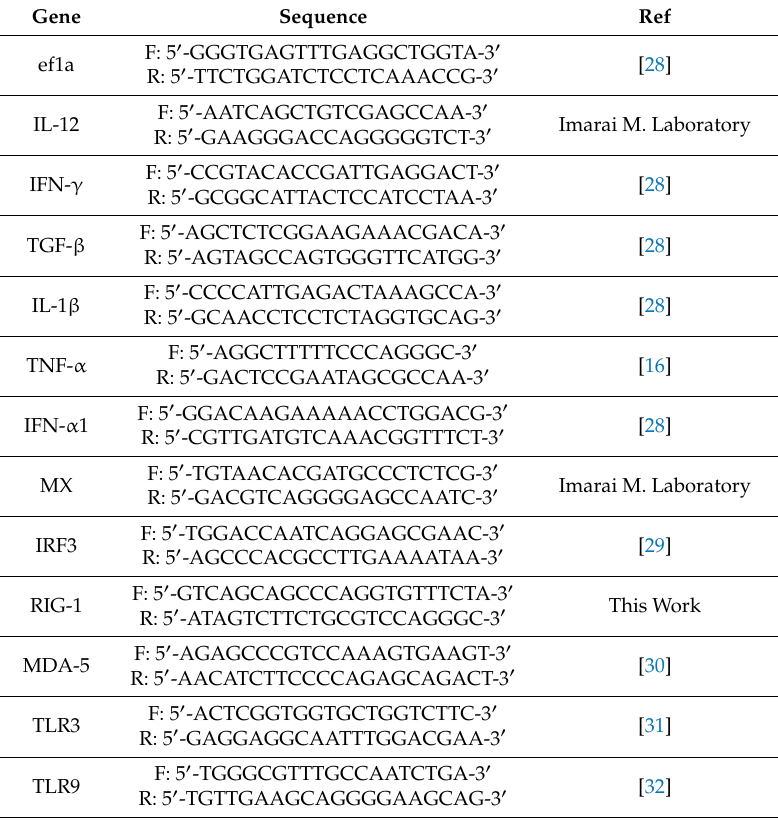
Table 1. Primers used to evaluate the expression of the immune response by